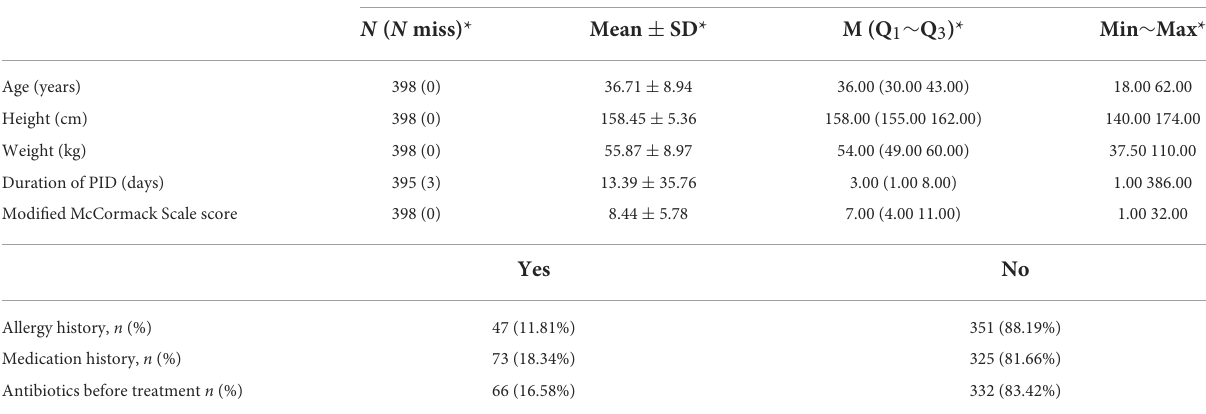
TABLE 2 Demographic and baseline